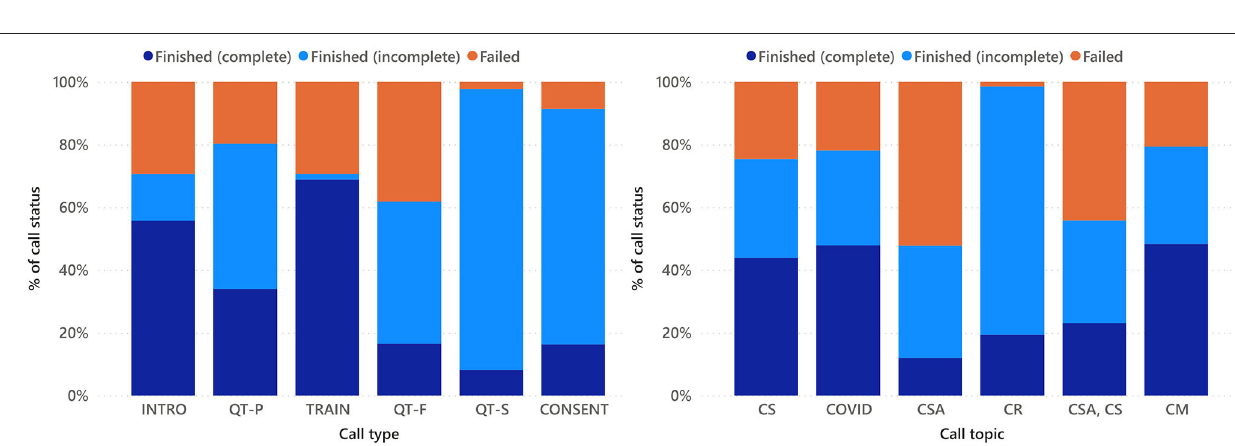
Frontiers in Sustainable Food Systems |